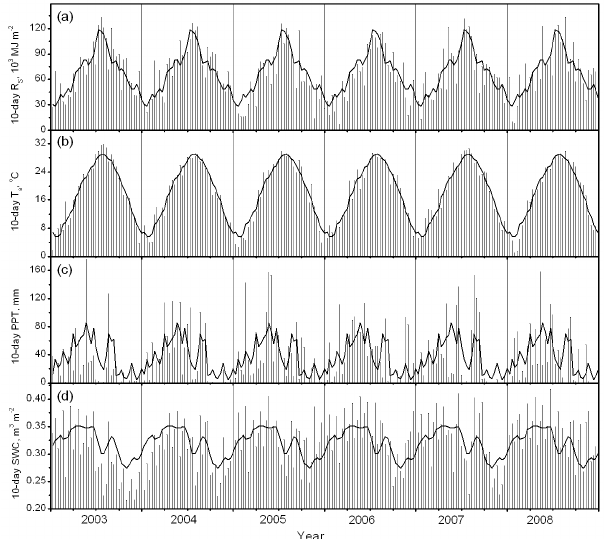
Fig. 2. The 10-day environmental conditions of QYZ site from 2003 to 2008: (a) downward solar radiation (R S , × 10 3 MJm − 2 ) , (b) air temperature ( T a , ◦ C), (c) precipitation (PPT, mm) and (d) soil water content (SWC, m 3 m − 3 ) . The drop lines and curves were the 10- day measurements and corresponding multi-year averages respec- tively.